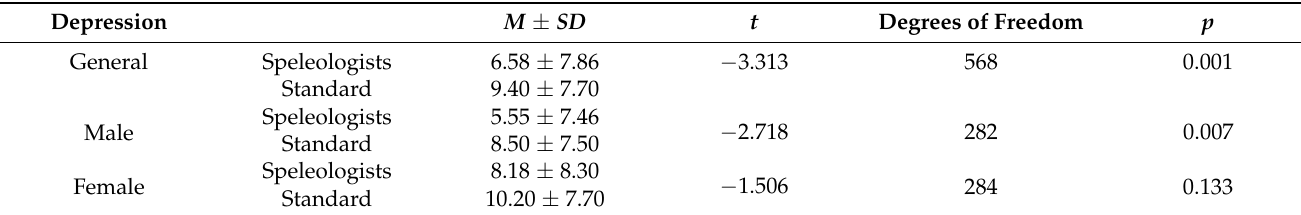
Table 3. Values for symptoms of depression in the sample of speleologists and the standard